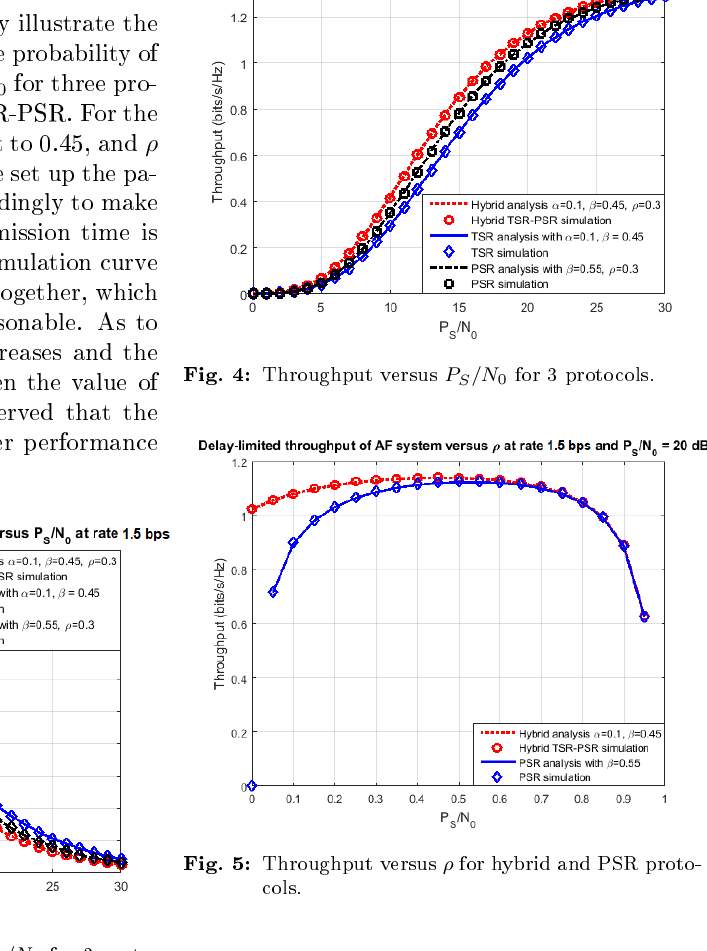
Fig. 3: Outgage probability versus P S /N 0 for 3 proto- cols.